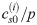
Mono-bacterial biofilm growth simulations.Mean of 50 simulations of the mean thickness at 3h, 24h and 48h with respect to the concentration of nutrients cs0(i)/p for different values of p: (a) P. gingivalis with N0(1)=175, (b) S. gordonii with N0(2)=315.